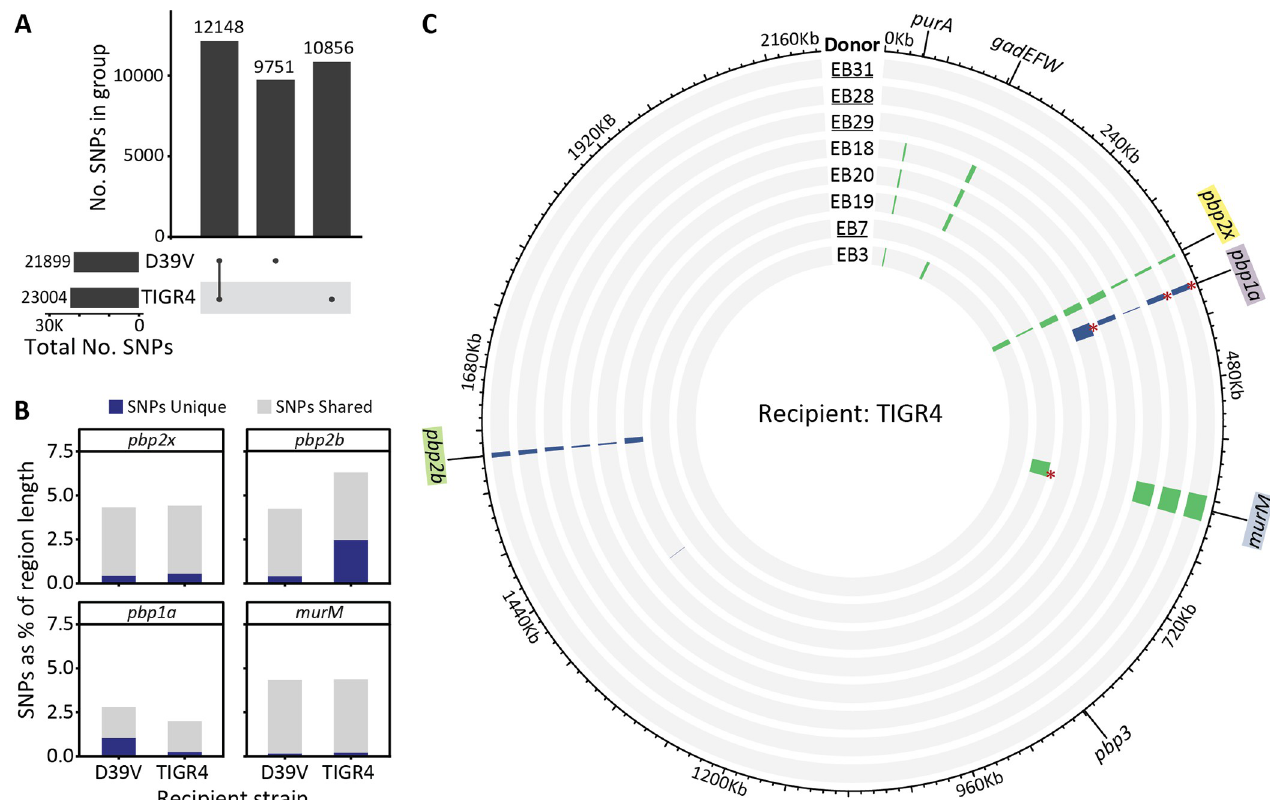
Fig 5. Uptake of four donor fragments is sufficient for AMX resistance in TIGR4. (A) Upset plot of shared and unique SNPs between each recipient and the donor. Bars on the left show the total number of SNPs for each recipient genome compared to the donor. In the central bar plot, from left to right, SNPs shared between D39V and TIGR4, SNPs found only in D39V, and SNPs found only in TIGR4. Although the two recipients differ from the donor strain by similar amounts of SNPs, only about half are unique. (B) SNP counts in pbp/murM genes, including 5 Kb up- and downstream. Number of SNPs unique to each recipient are shown in blue, and shared in light grey. (C) Circos plot showing detected recombination events in TIGR4 derived strains, arranged from lowest to highest MIC from inside to out. EB7 and all derived strains are underlined, EB3 and all derived strains are not. Grey indicates the sequences matches that of the recipient D39V, while recombination events are colored. Events acquired in the first round of transformation are shown in green, and in the second round in blue, and lengths were increased to aid in visualization (see S3 Table for a list of all detected events). Only six loci with recombination were identified in the entire data set, four of which are known β -lactam resistance determinants, pbp2x , pbp2b , murM , pbp1a